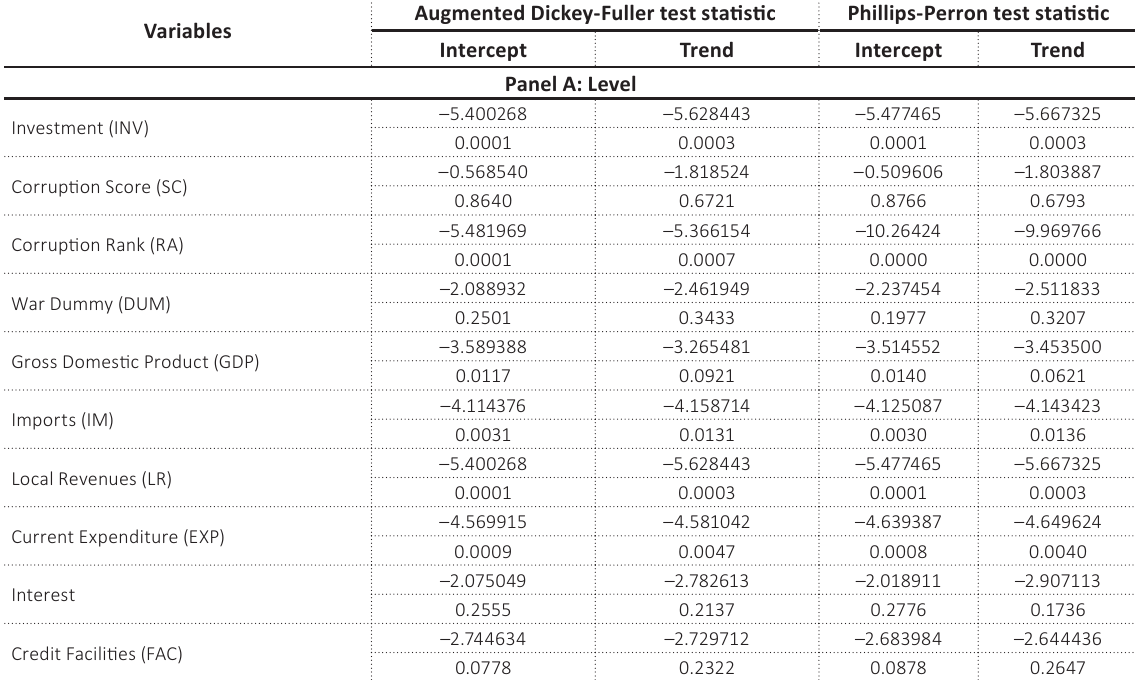
Table 2. The results of augmented Dickey-Fuller and Phillips-Perron